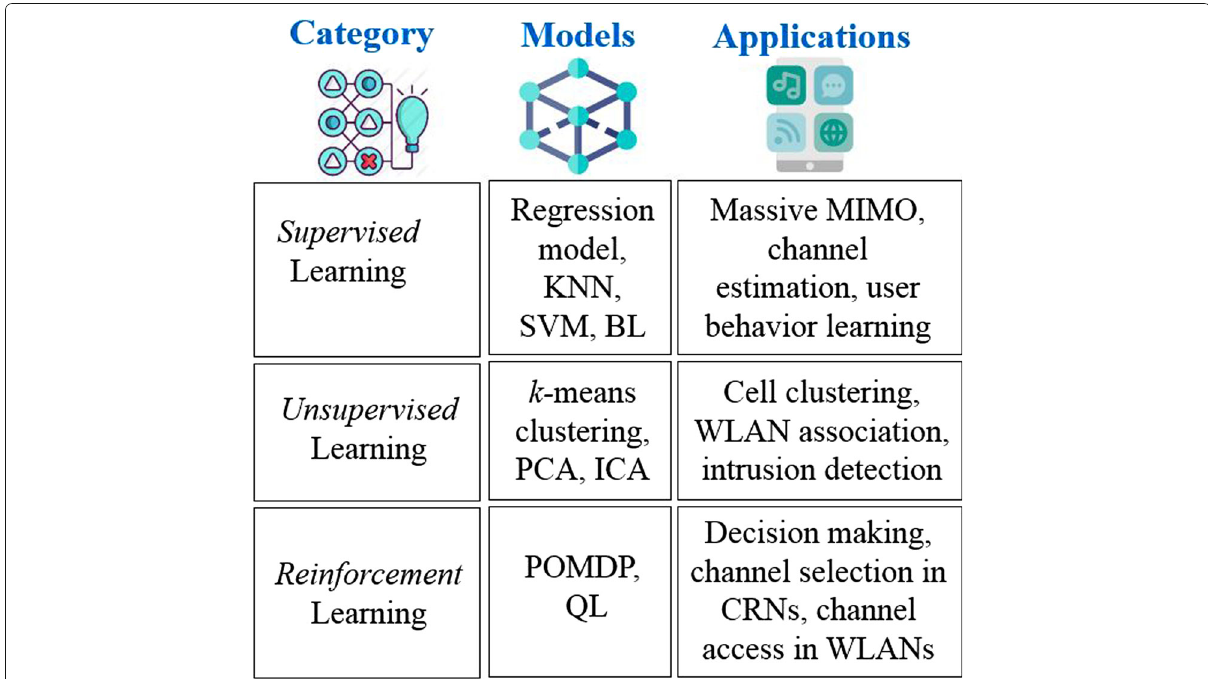
Fig. 3 Machine learning family architecture models and their potential applications in dense IoT systems